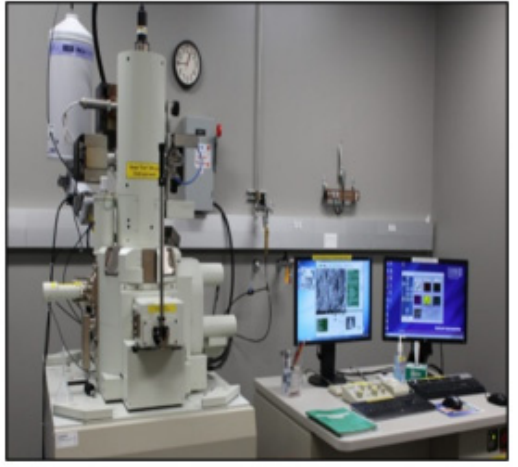
Figure 5. Setup of Scanning Electron Microscopy.